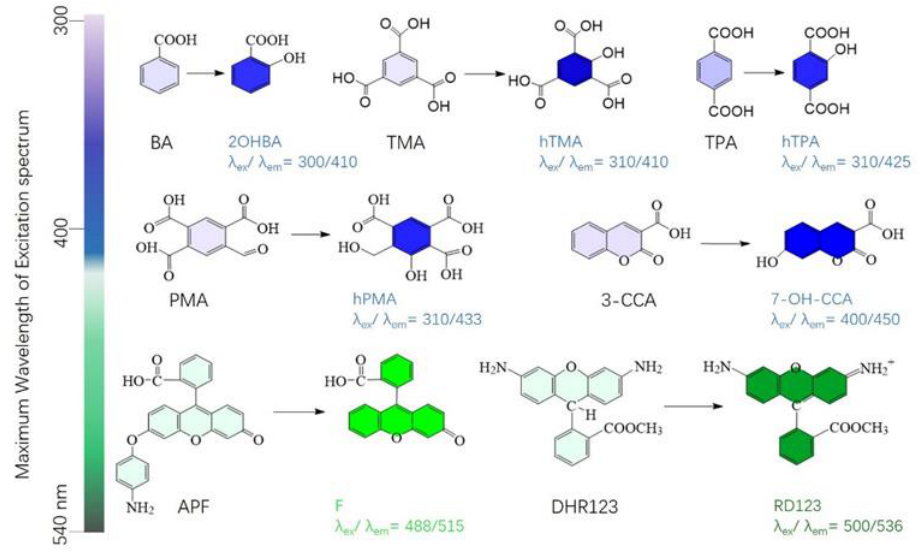
Figure 6. Representative radio-fluorogenic molecules.